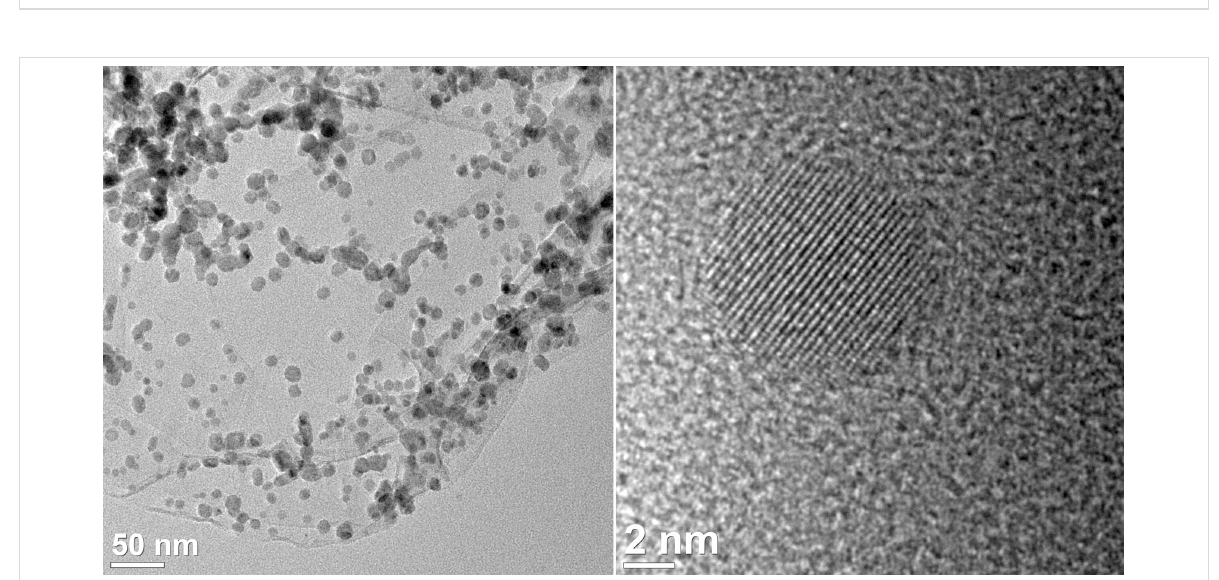
Figure 2: TEM images of PrF 3 @TRGO-400 dispersions from [Pr(AMD) 3 ] in [BMIm][BF 4